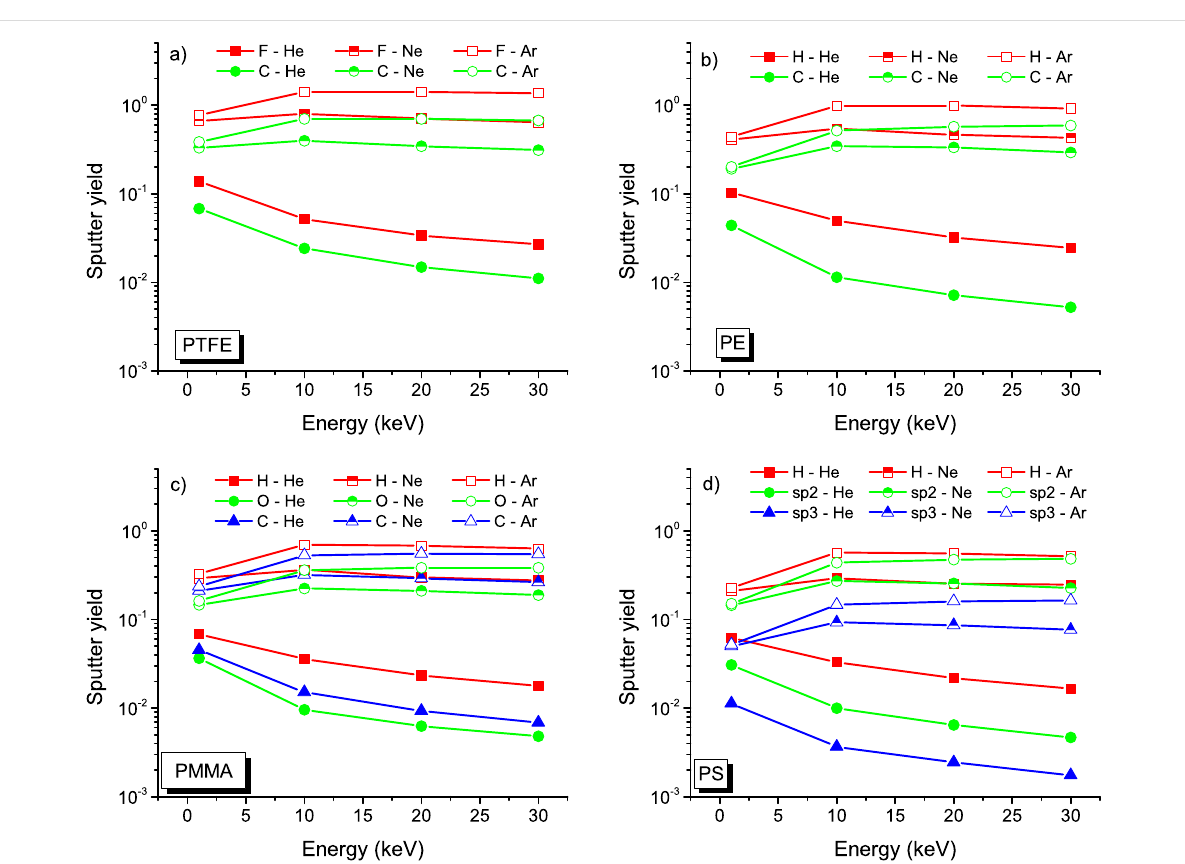
Figure 10: Partial sputter yields for the different chemical elements sputtered from a) PTFE, b) PE, c) PMMA, and d) PS for helium, neon and argon irradiation at a fluence of 10 18 ions/cm 2 .